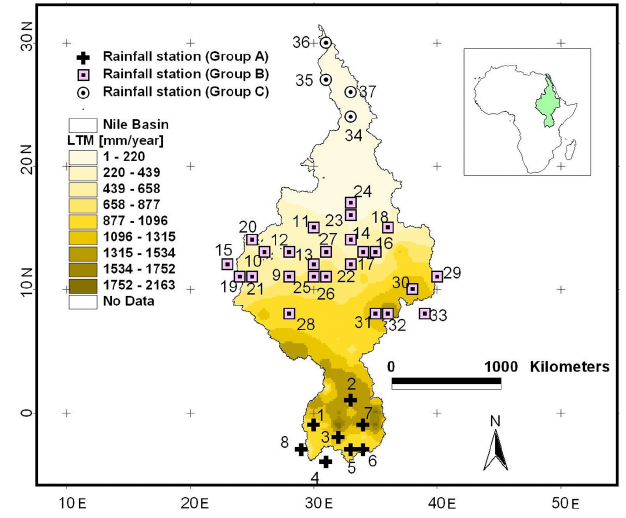
Figure 1. Locations of the selected meteorological stations (see Ta- ble 1 for details) in the Nile Basin; the background is based on the long-term mean (LTM) of annual